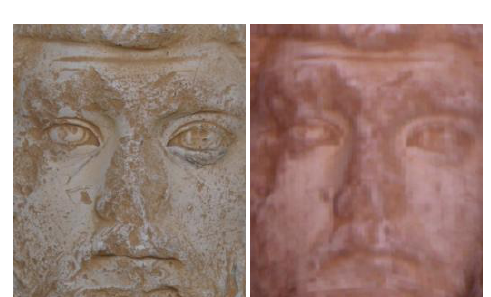
Figure 7a, b. Texture 1f.tif and 1s.tif